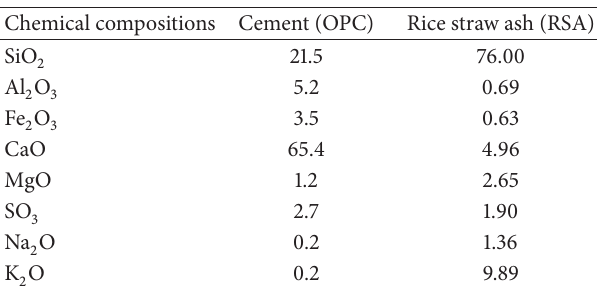
Table 2: Chemical properties of OPC and RSA.